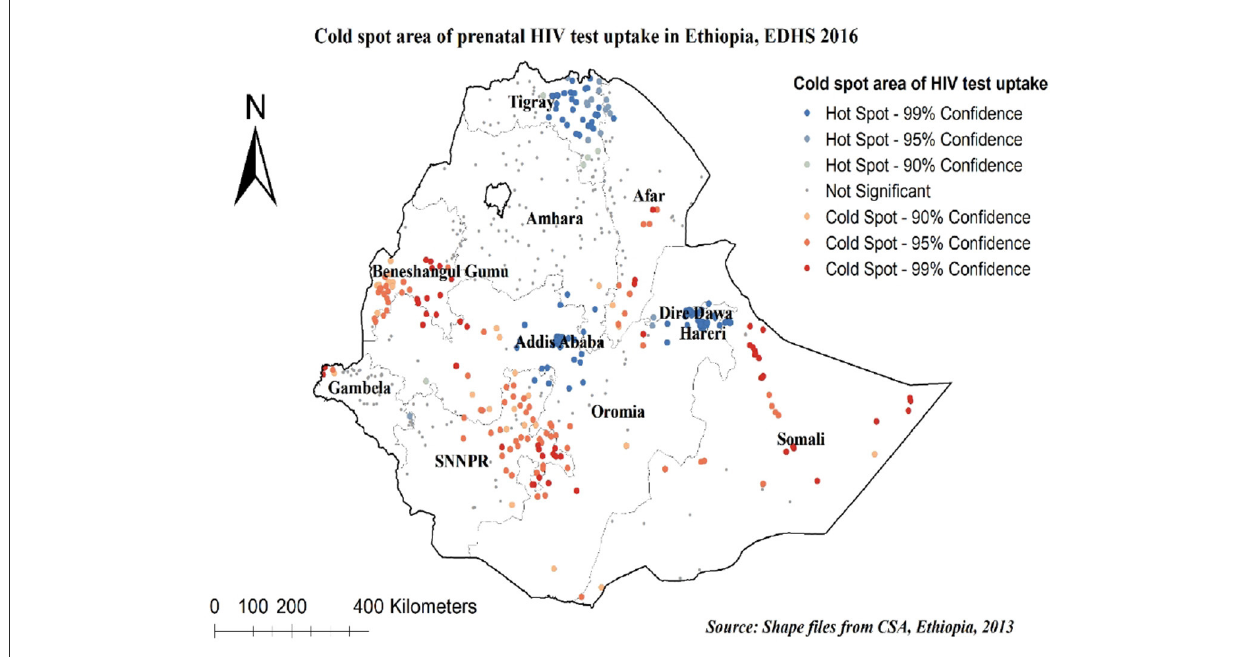
FIGURE3 Hot spot and cold spot identifications of prenatal HIV test uptake in Ethiopia, 2016.